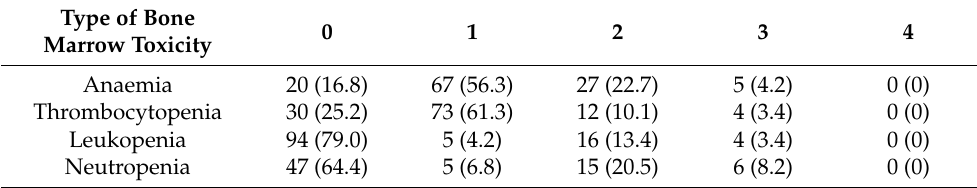
Table 2. Presence of bone marrow toxicity according to CTCAE, n